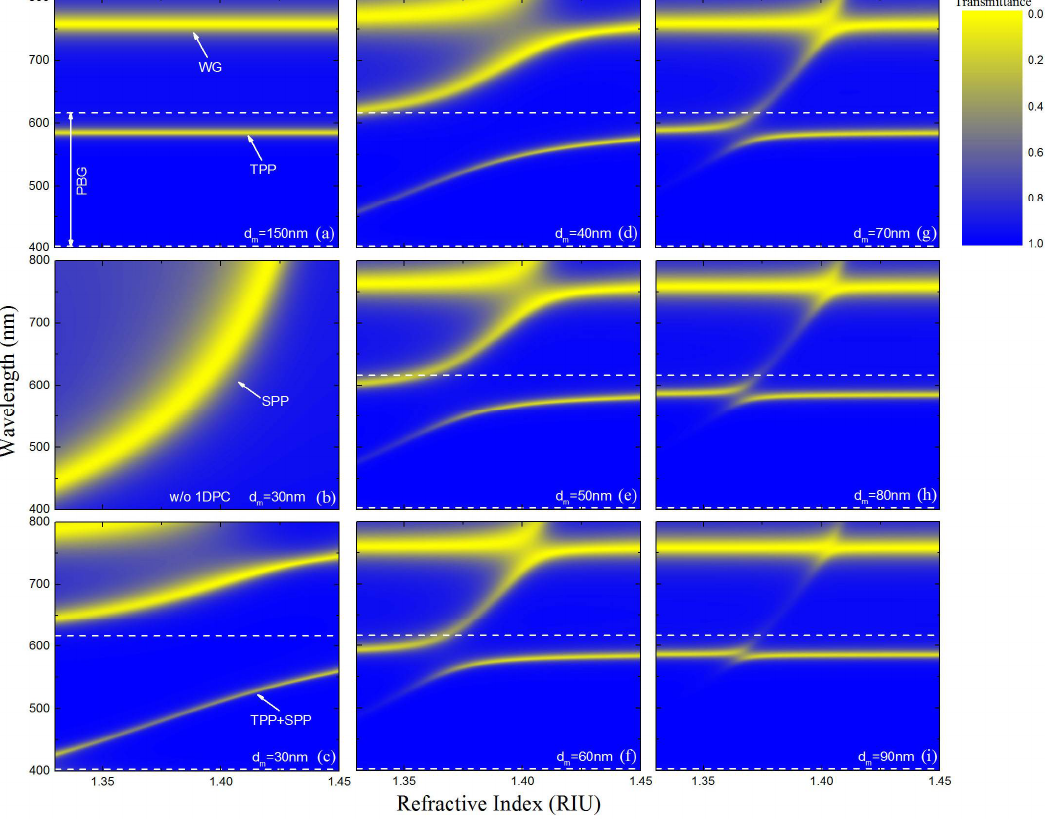
Figure 5. Two-dimensional contour maps of normalized transmittance calculated through the proposed sensor as a function of wavelength and RI of the sensed medium at N = 3, λ 0 = 1000 nm. ( a ) d m = 150 nm, ( b ) without 1 DPC, d m = 30 nm, ( c ) d m = 30 nm, ( d ) d m = 40 nm, ( e ) d m = 50 nm, ( f ) d m = 60 nm, ( g ) d m = 70 nm, ( h ) d m = 80 nm, ( i ) d m = 90 nm.